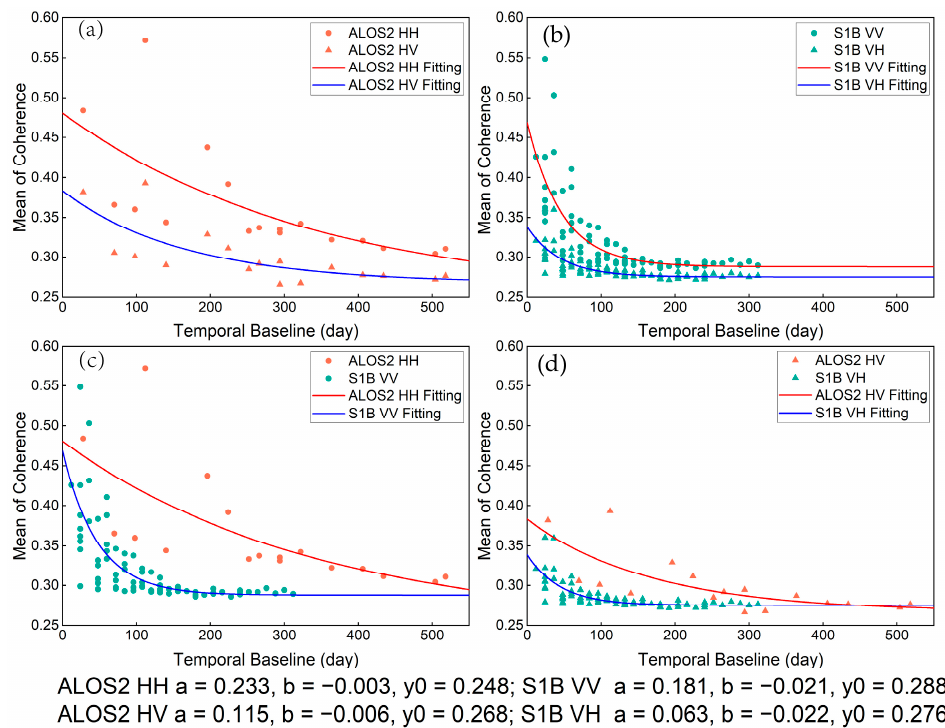
Figure 6. Correlation between temporal baseline and coherence in different polarization modes of ALOS2 and S1B. ( a ) ALOS2 HH vs. ALOS2 HV; ( b ) S1B VV vs. S1B VH; ( c ) ALOS2 HH vs. S1B VV; ( d ) ALOS2 HV vs. S1B VH. The red and green lines show the fitting lines of the mean coherence, respectively.